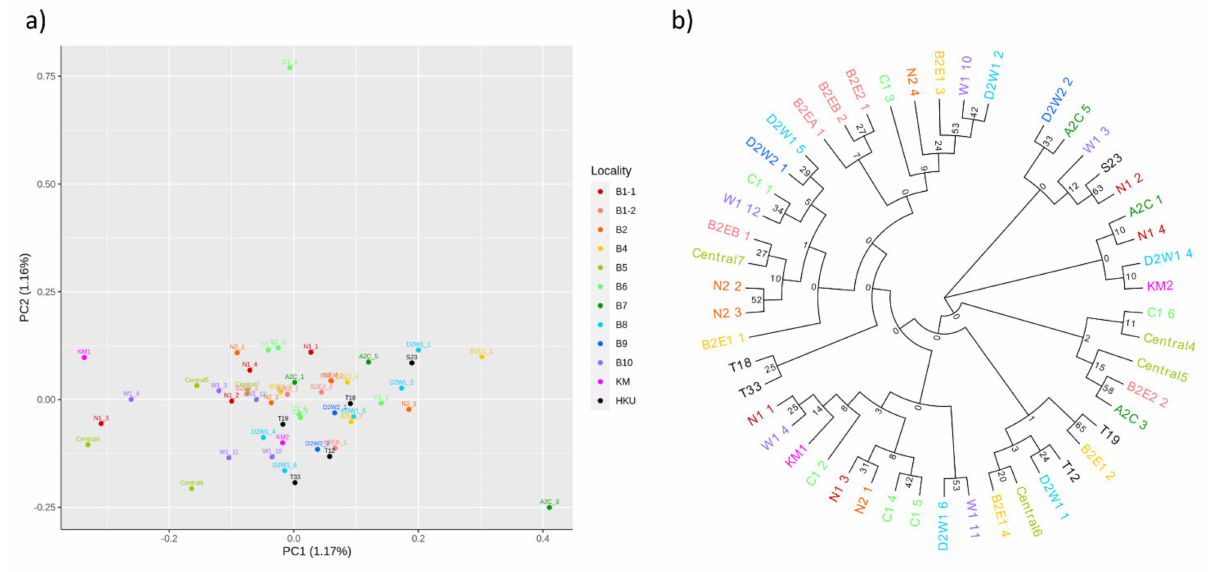
Figure 2. Population relationships of the collected M. hongkongensis individuals. ( a ) Principal component analysis based on genetic differences. ( b ) Neighbour-joining tree of individuals based on filtered